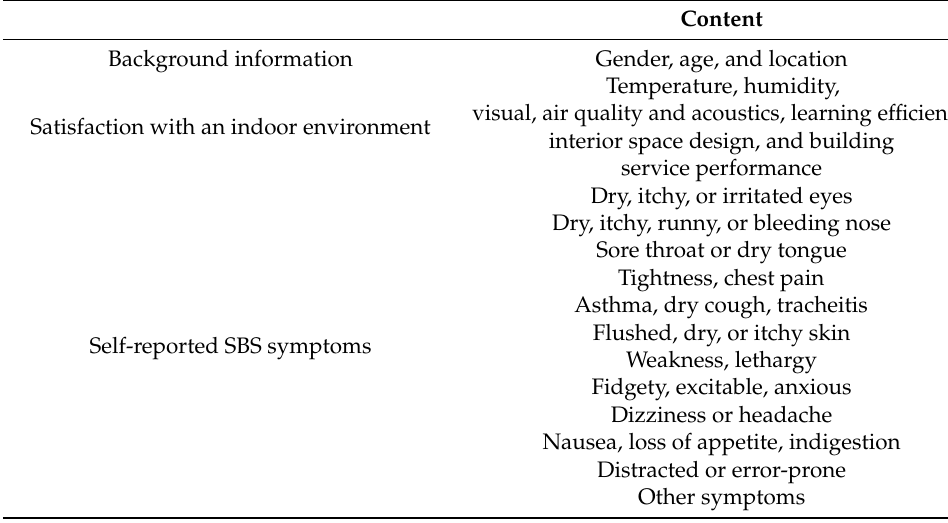
Table 5. Questionnaire content